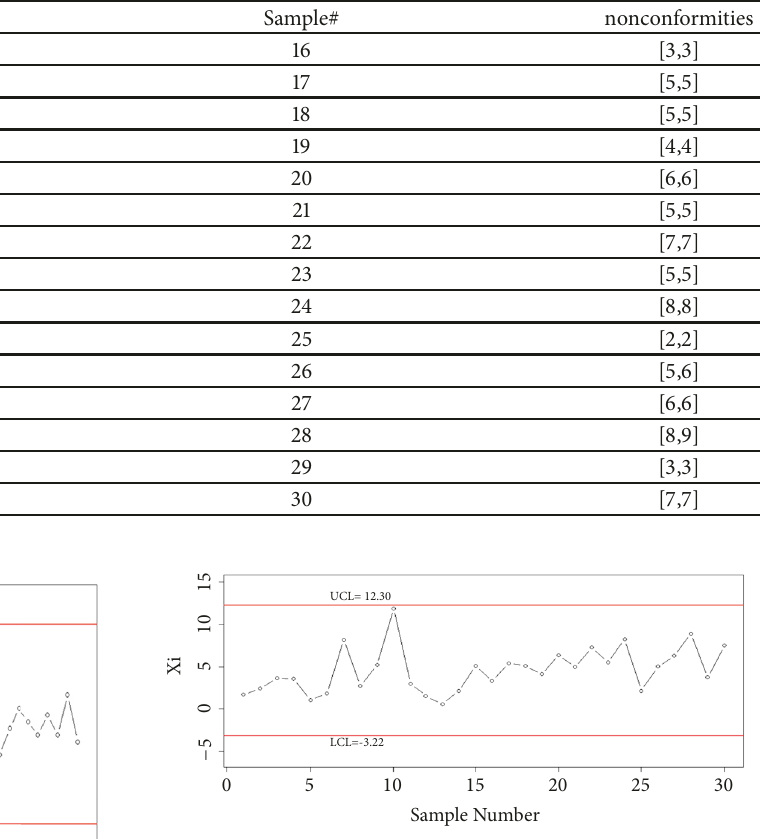
Figure 4: The existing control chart for the real